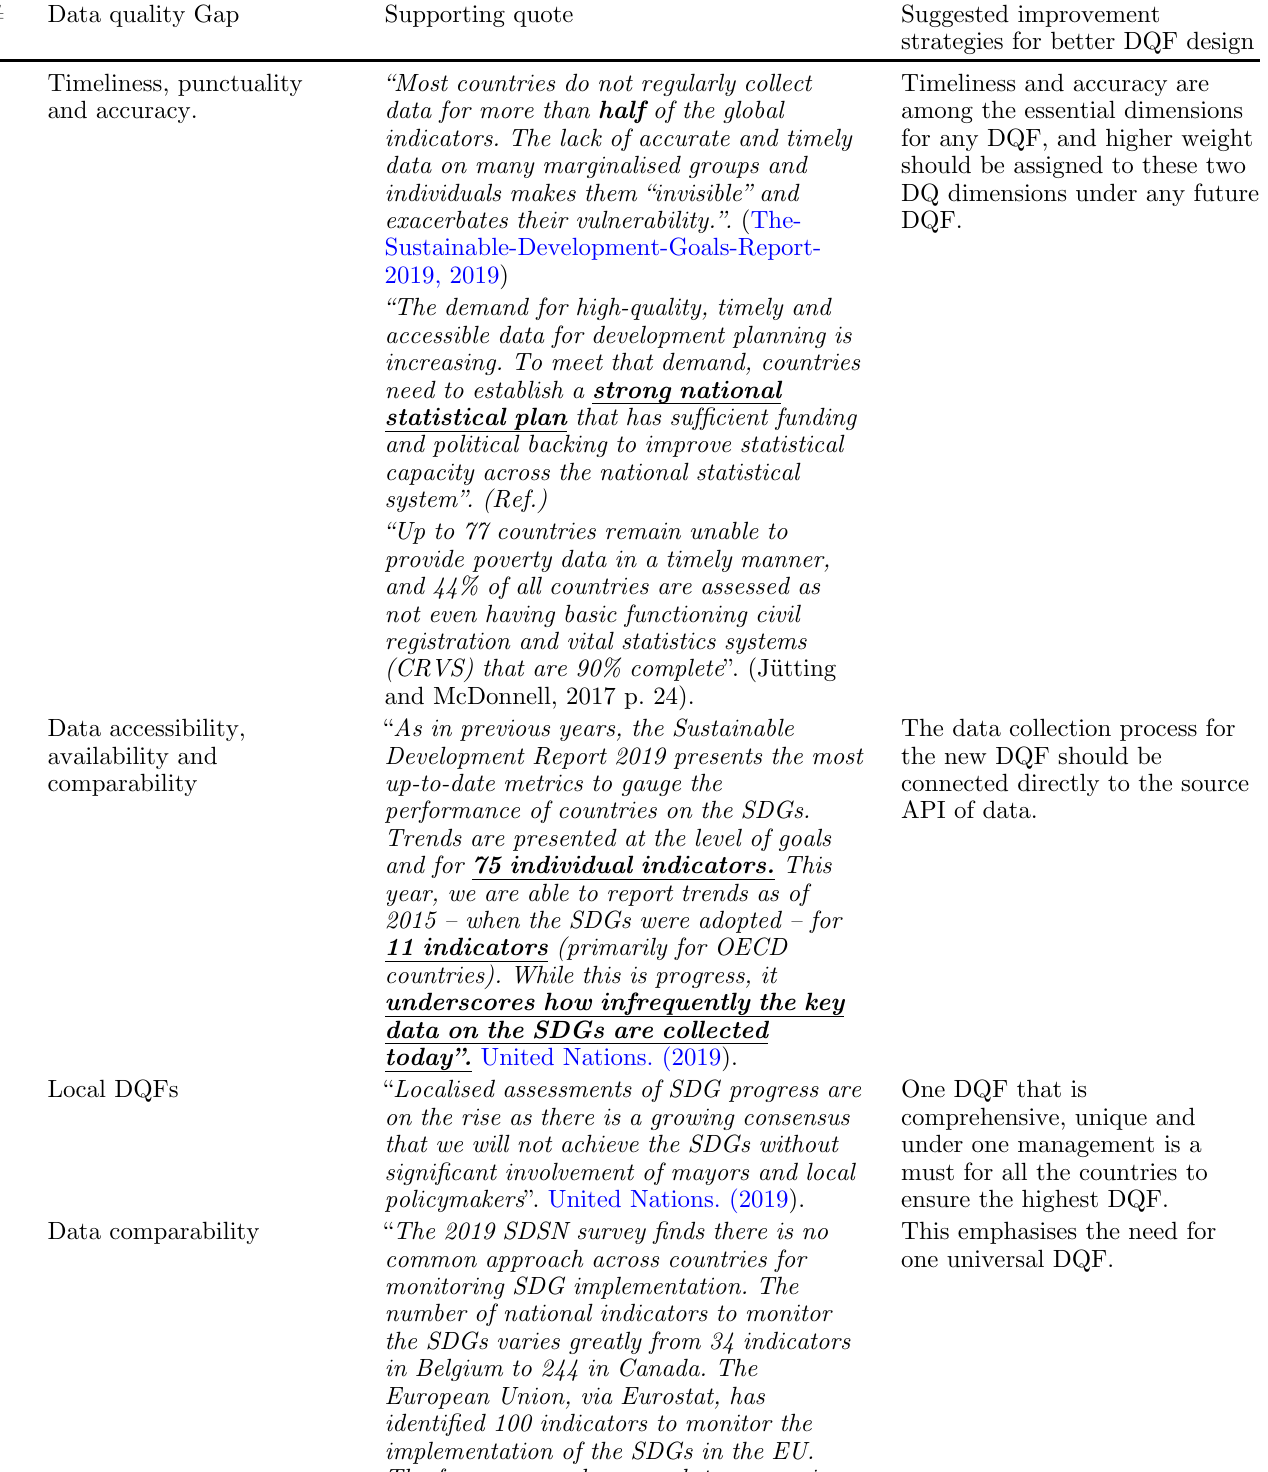
Table 5. Data quality gaps for the UN SDG report according to current literature and reports. # Data quality